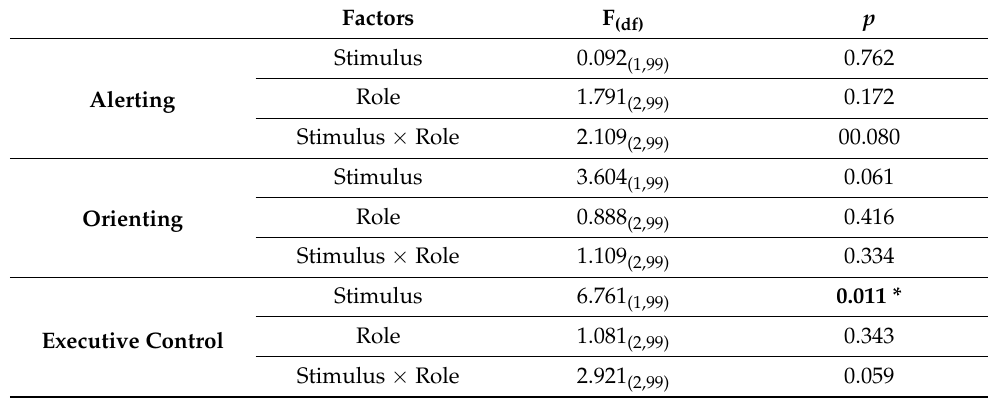
Table 2. The 2 × 3 mixed ANOVA outputs for RTs. Bold values represent significant (* p < 0.05) results.